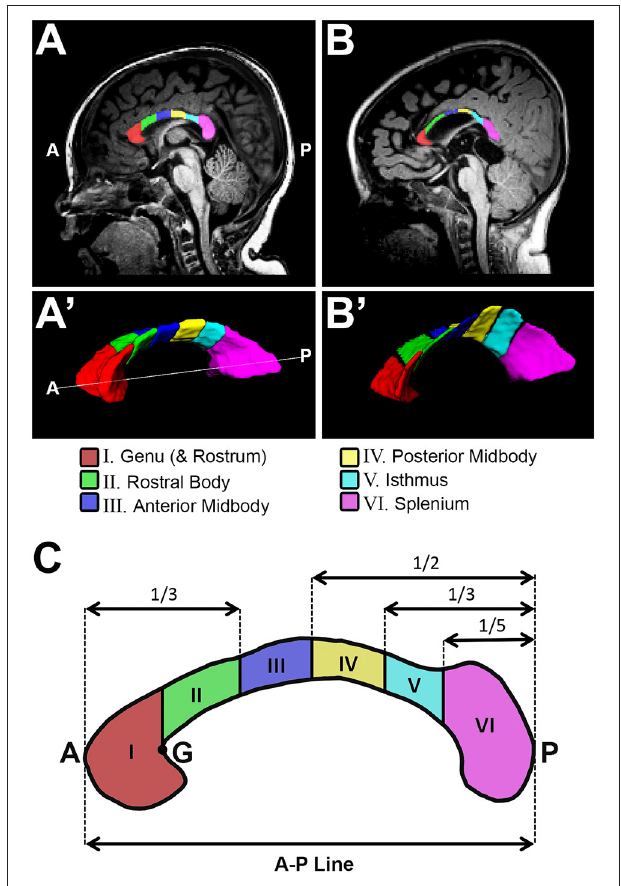
FIGURE 1 | Sub-regional corpus callosum analysis. Representative T1-weighted corpus callosum (CC) segmentation for a term-born otherwise healthy control (A,A’) and a term-born patient (B,B’) scanned at 10 and 9 months of age, respectively. Volumes of CC were estimated for a total of 6 CC sub-regions (C) . Sub-regional segmentation used the proportion-based parcellation scheme originally proposed by Witelson ( 23), with slight modification based on Venkatasubramanian et al. ( 37) (see Methods for details). A, anterior; G, genu; P,